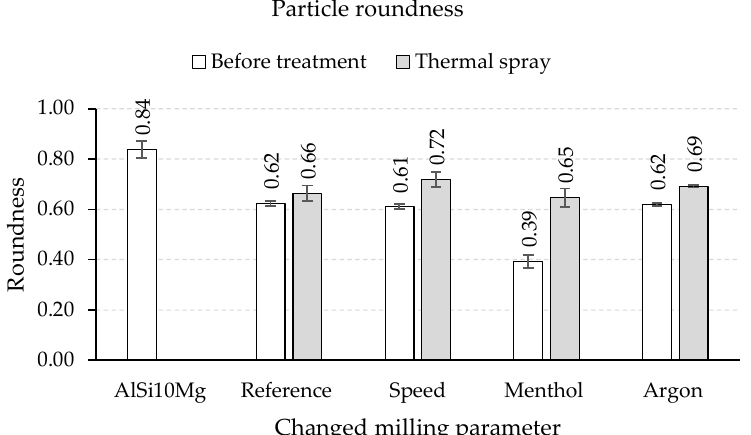
Figure 14. Particle roundness of HEBM-powder treated by means of thermal sprayed HEBM-powder.